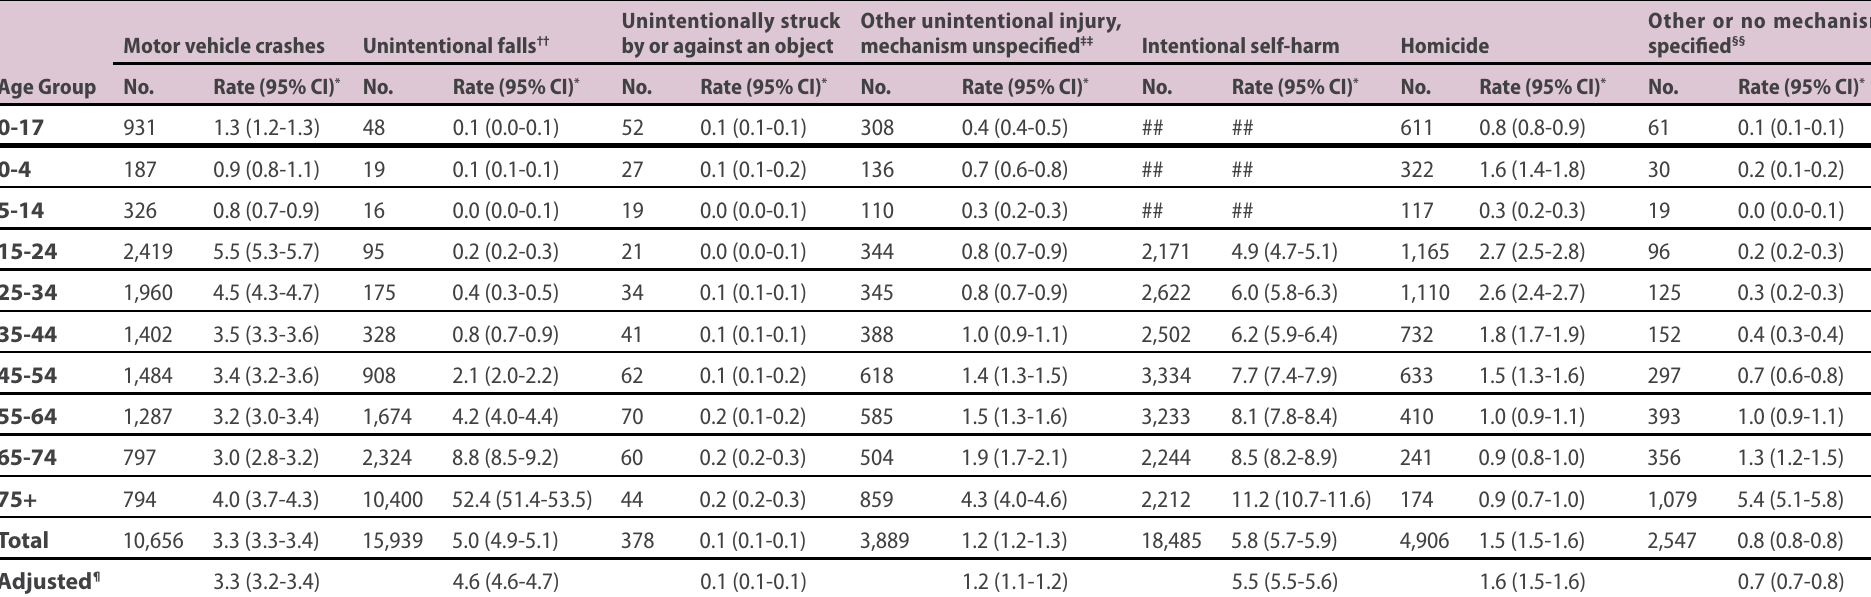
TABLE 4: NUMBER AND RATE OF TRAUMATIC BRAIN INJURY-RELATED DEATHS, BY AGE GROUP AND MECHANISM OF INJURY — UNITED STATES,